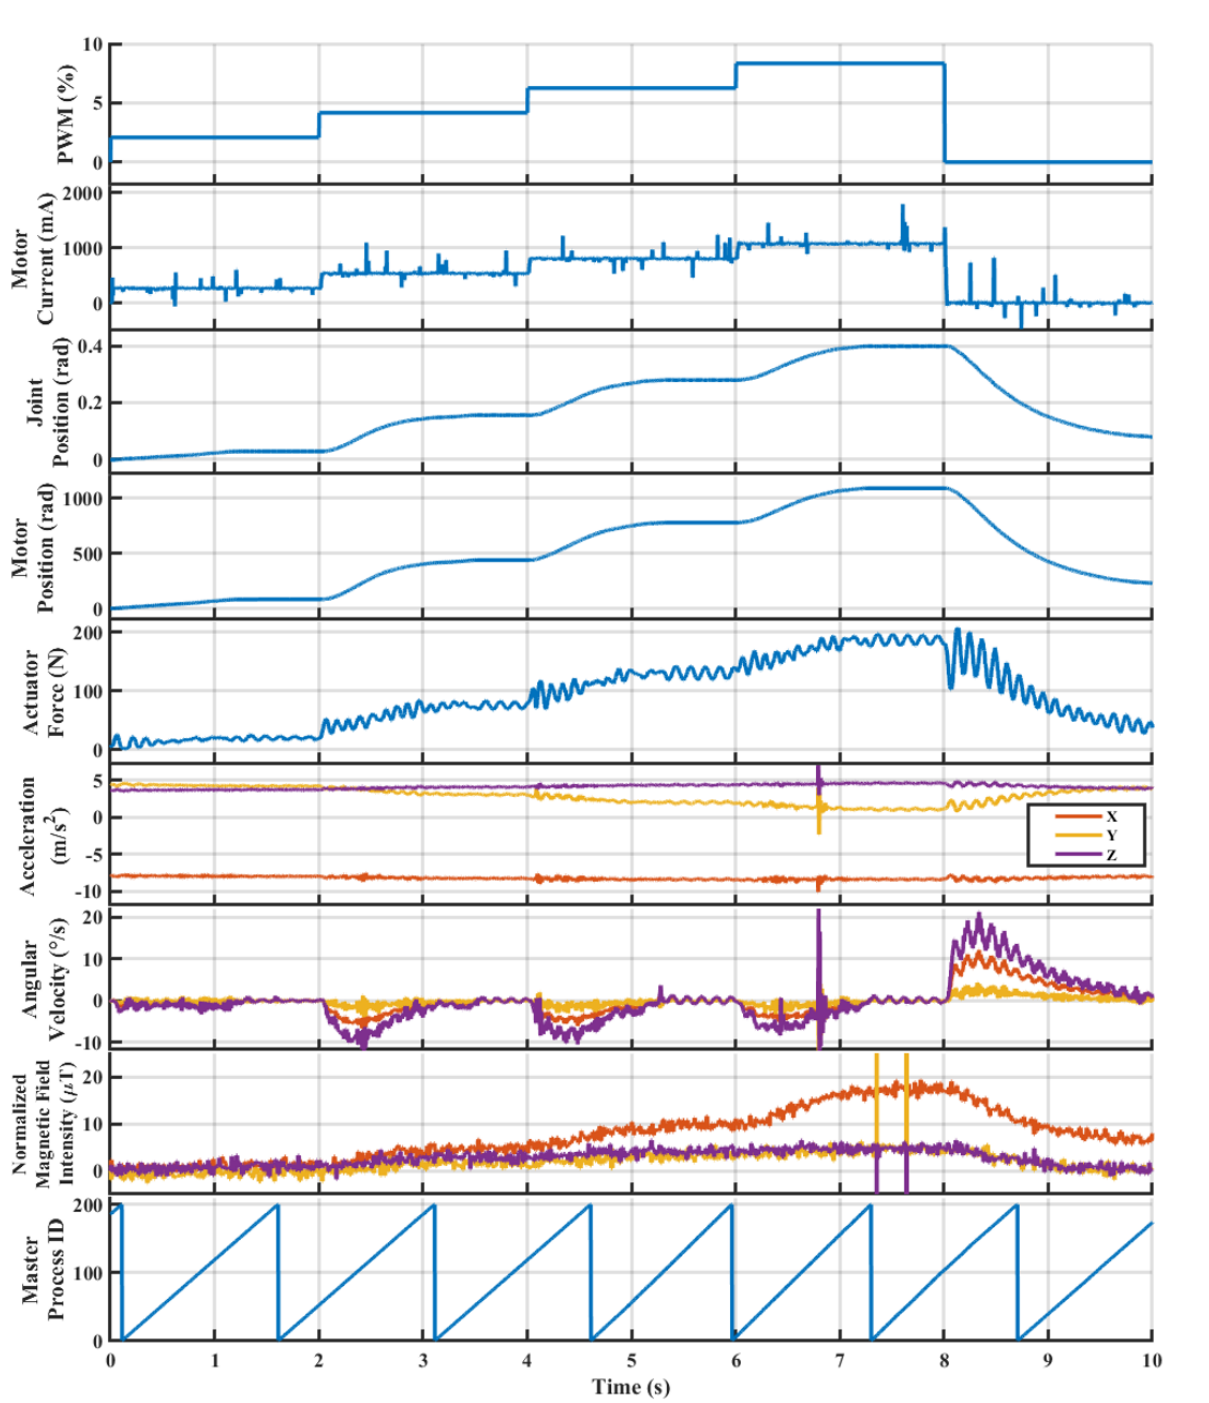
Figure 15. Hardware performance for an open − loop step − wise input of 250 mA, 500 mA, 750 mA, and 1000 mA amplitude on the pendulum test